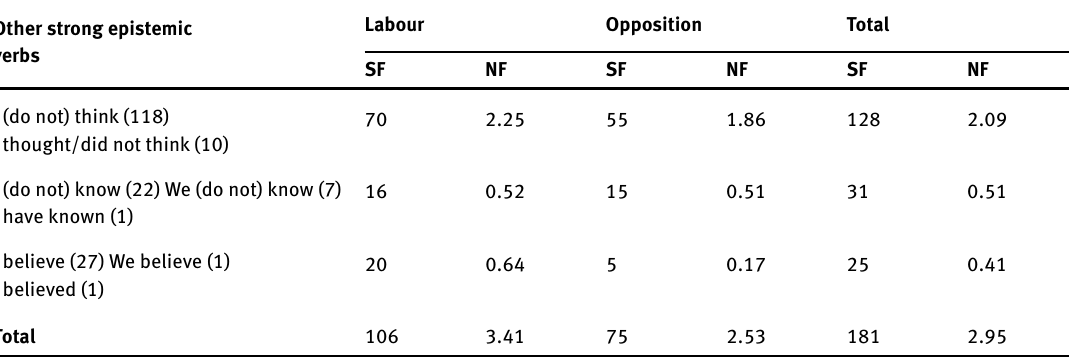
Table 4: Other strong epistemic verbs.